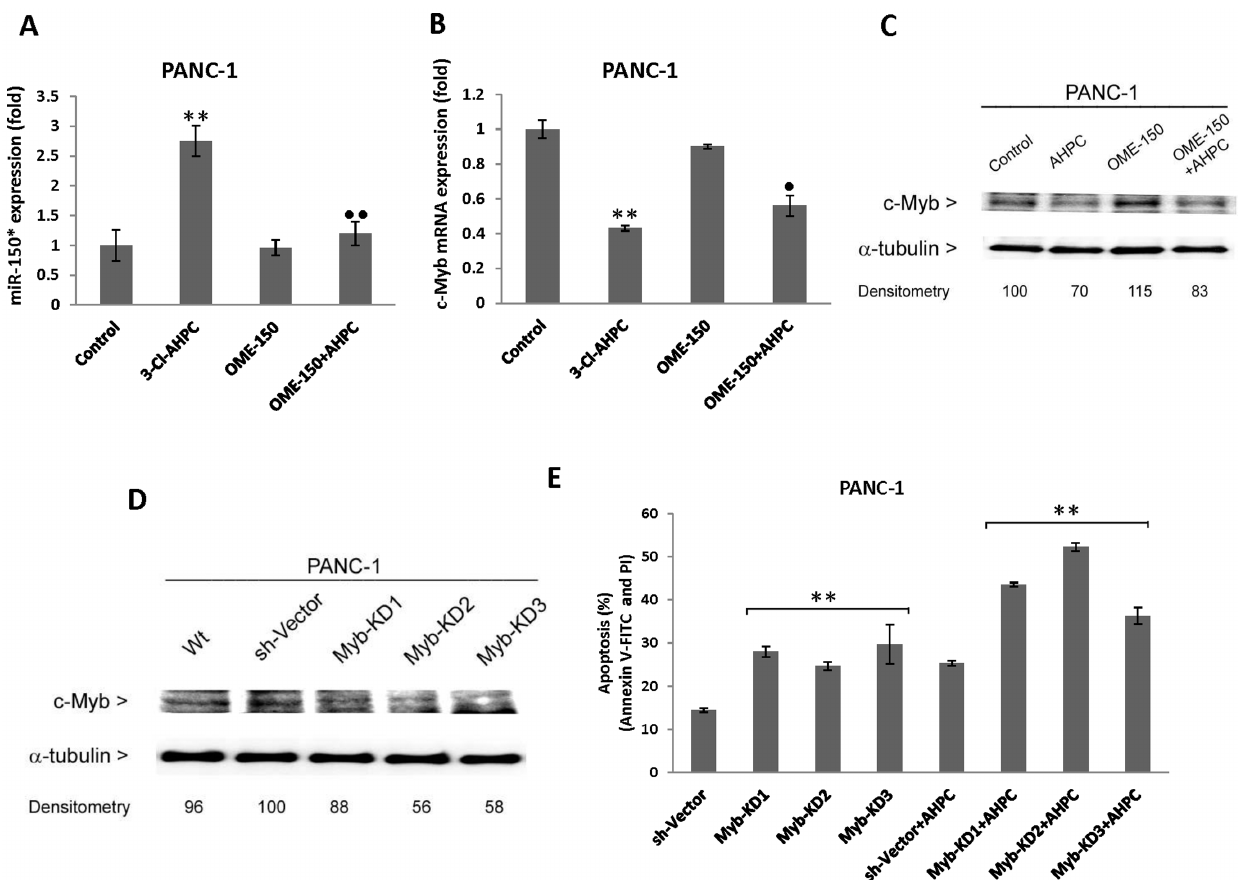
Figure 4. Inhibitor of miR-150* blocked 3-Cl-AHPC-mediated decreased of c-Myb in PANC-1 cells. (A) Inhibitor 2 9 -O-methylated miR- 150* (OME-150) inhibited 3-Cl-AHPC mediated miR-150* expression in transiently transfected cells. (B and C) miR-150 inhibitor blocked the 3-Cl-AHPC mediated c-Myb degradation. Cells were treated with 1 m M 3-Cl-AHPC for 24 h. (D) Knock down of c-Myb expression in cells. (E) Knock down of c-Myb enhanced the apoptosis in cells. Cells stably transfected with three sh-Myb knockdown expression vectors and scrumble sequence control vector were exposed to 3-Cl-AHPC for 24 h. Induction of apoptosis was assessed using Annexin V-FITC labeling with propidium iodide (PI) staining in cells N NN N and the error bars represent the mean of three separate determinations 6 the standard deviation (SD). All treated samples and sh-Myb are and , ** ( , 0.05 and , 0.01 respectively) are significantly different by t -Test and represented significantly different from control and sh-vector; the comparison between 3-Cl-AHPC to OME-150* + 3-Cl-AHPC treated